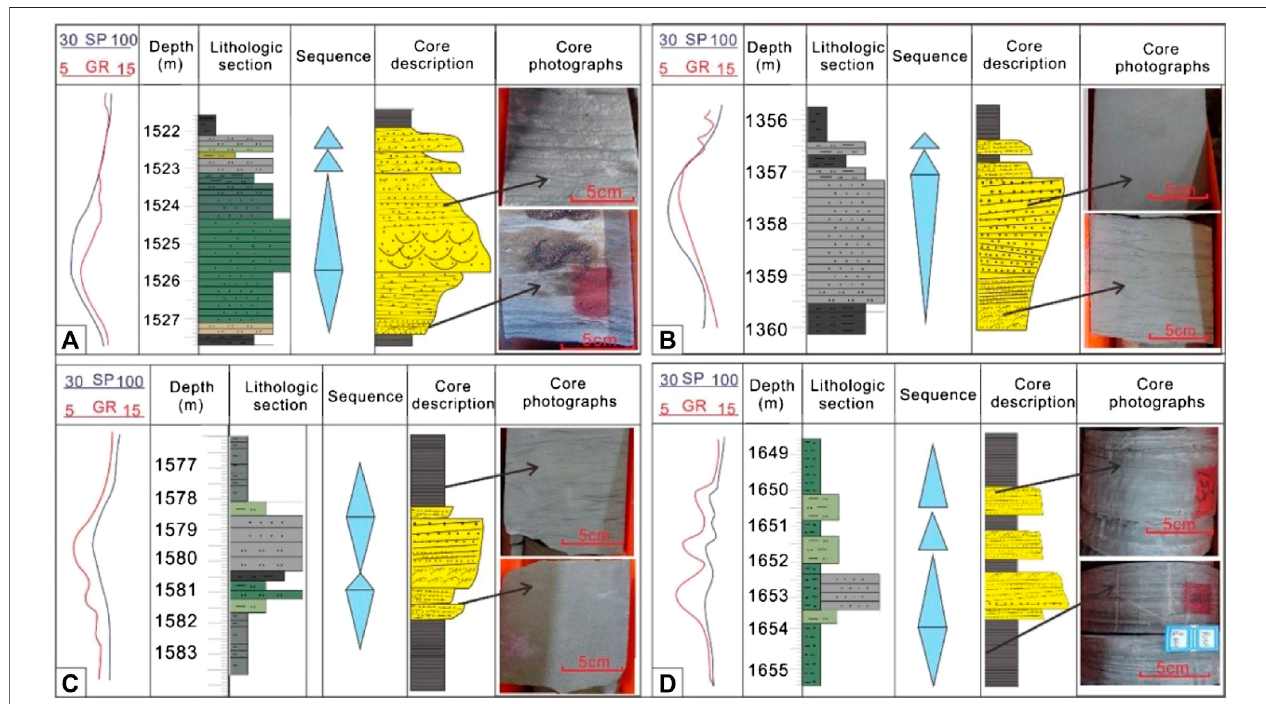
FIGURE 8 | Characteristics of the microfacies: (A) characteristics of subaqueous distributary channel and mouth bar, HB79; (B) characteristics of mouth bar, HB56; (C) characteristics of sand sheet, HH9; (D) characteristics of interdistributary bay- fi ll, HB178.